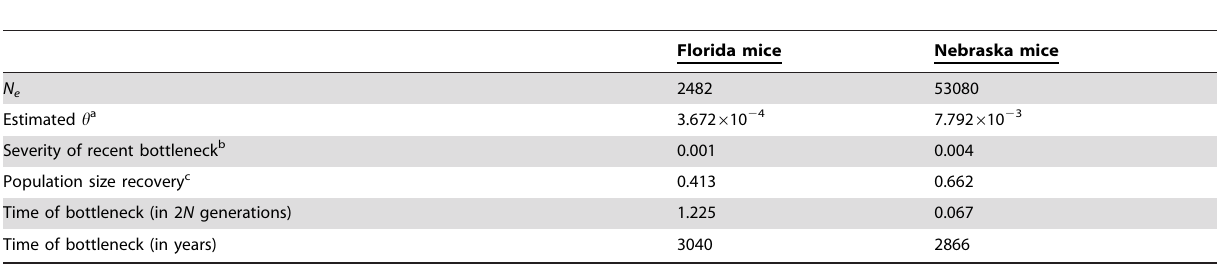
Table 1. Comparison of demographic parameters in Florida mice and Nebraska